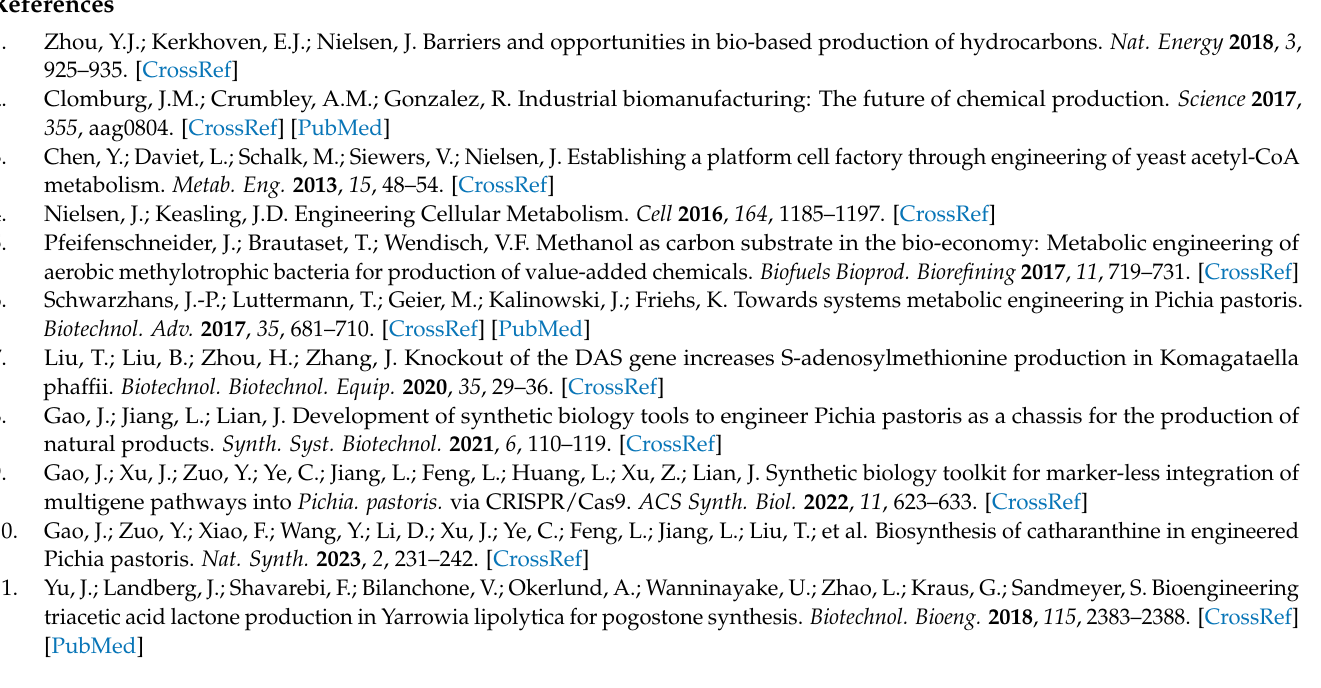
primers. Table S3: List of gene coding sequences. Table S4, TAL titer, yield, and productivity in various strains from different carbon sources. Figure S1: Schematic diagram of plasmid and strain construction process in this study. Figure S2: HPLC analysis for TAL identification and quantification. Figure S3: TAL production from